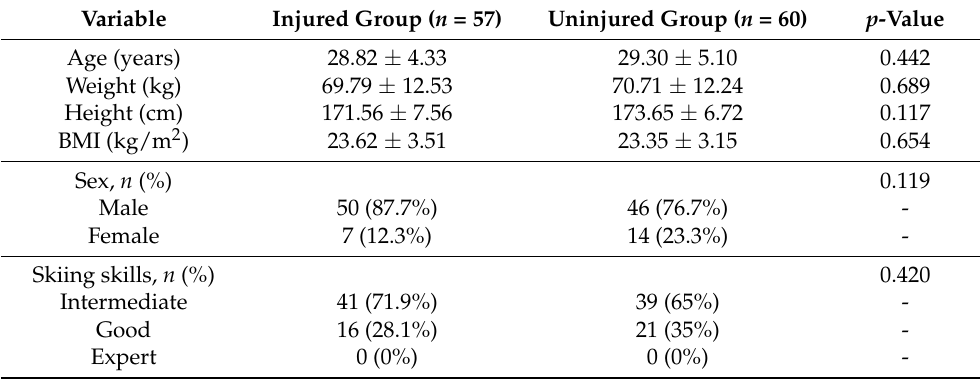
Table 3. Characteristics of the participants (Mean ±